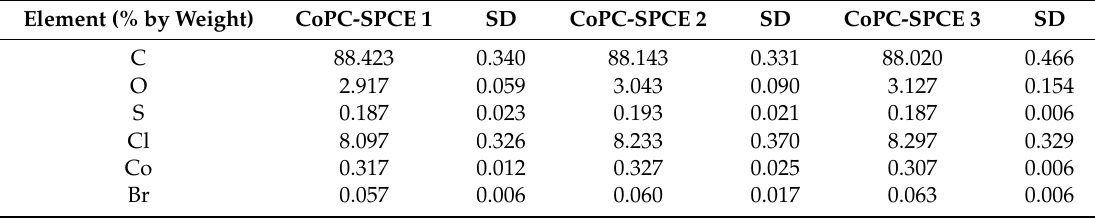
SD = standard deviation.